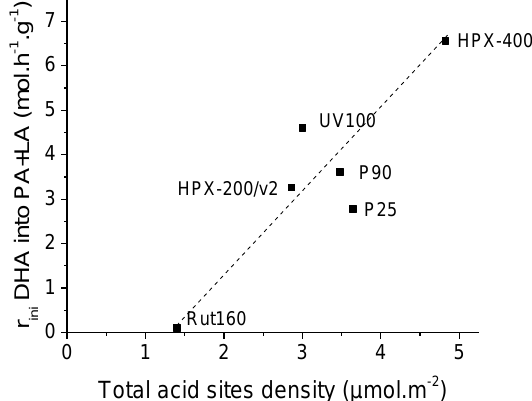
Figure 9 . Increase of initial rates of pyruvaldehyde and lactic acid formation with TiO 2 ′ s total acid sites density.